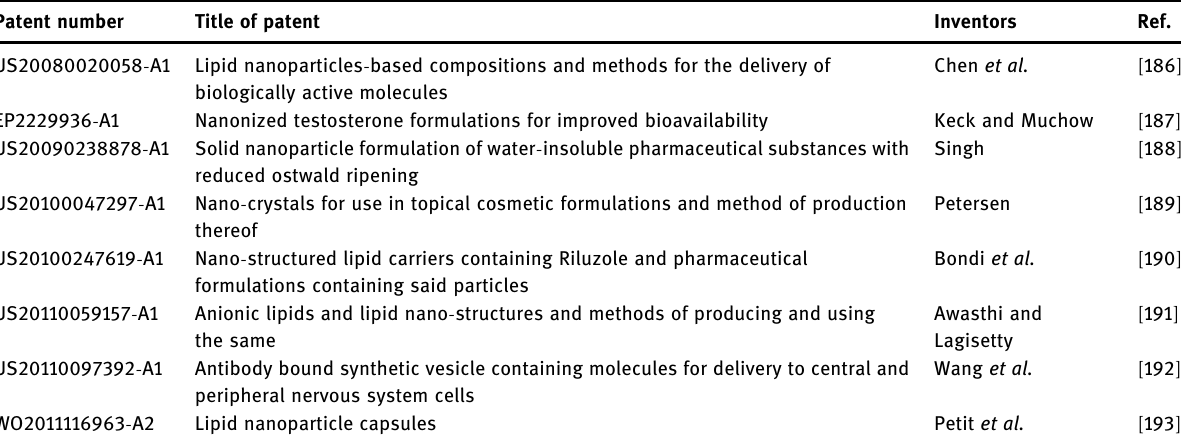
Table 6: Patents granted on NLCs in the fi eld of applications in drug